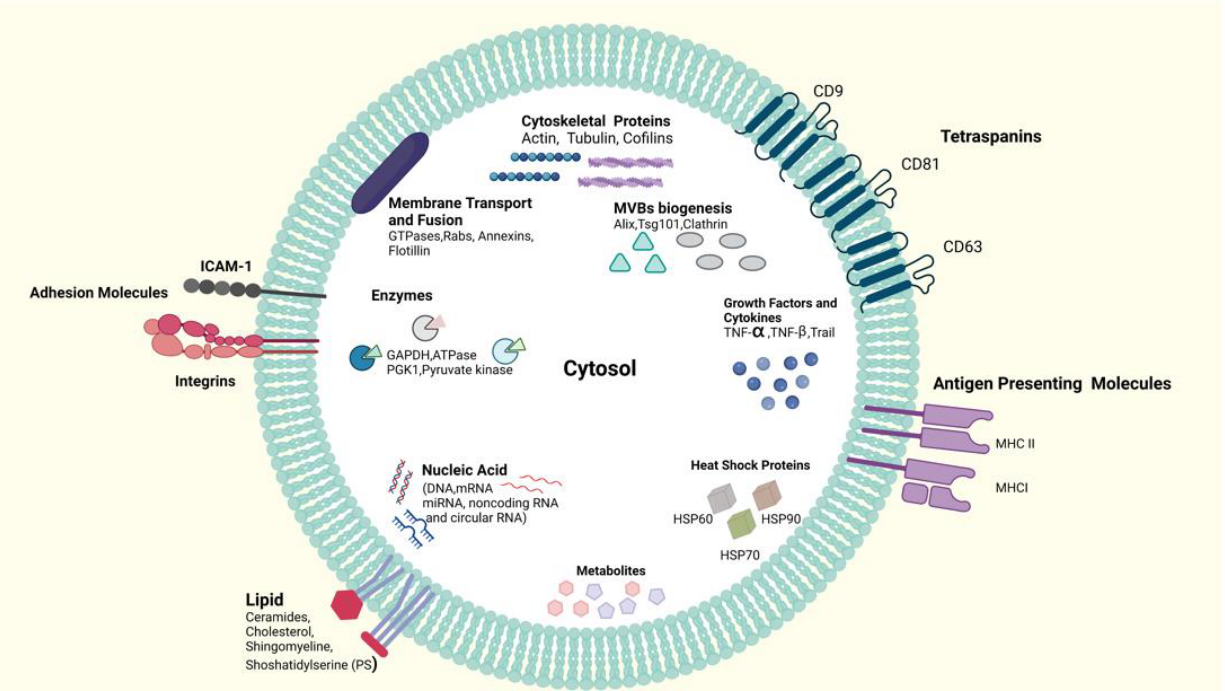
Figure 3. The main components of an EV. EVs are packed with a diverse array of molecules, such as lipids, proteins, nucleic acids (DNA, mRNA, miRNA, non-coding RNA, and circular RNA), and metabolites. In addition to sphingomyelin, phosphatidylserine (PS), cholesterol, and ceramides make up the lipid bilayer of EVs. EVs include tetraspanins, antigen-presenting molecules, and adhesion molecules. Furthermore, heat shock proteins (HSPs), cytoskeletal proteins, MVB biogenesis, enzymes, membrane transport, fusion proteins, growth factors, and cytokines are all proteins present in the EV lumen. Abbreviations in the figure: MVBs, multivesicular bodies; GAPDH, glyceraldehyde3-phosphate dehydrogenase; HSP, heat shock protein; MHCI, major histocompatibility complex class I; MHCII, major histocompatibility complex class II; miRNA, microRNAs; Tsg101, tumor susceptibility gene 101; TNF, tumor necrosis factor; TRAIL, TNF-related apoptosis-inducing ligand; ICAM-1, intercellular adhesion molecule 1; and PGK, phosphoglycerate kinase 1.